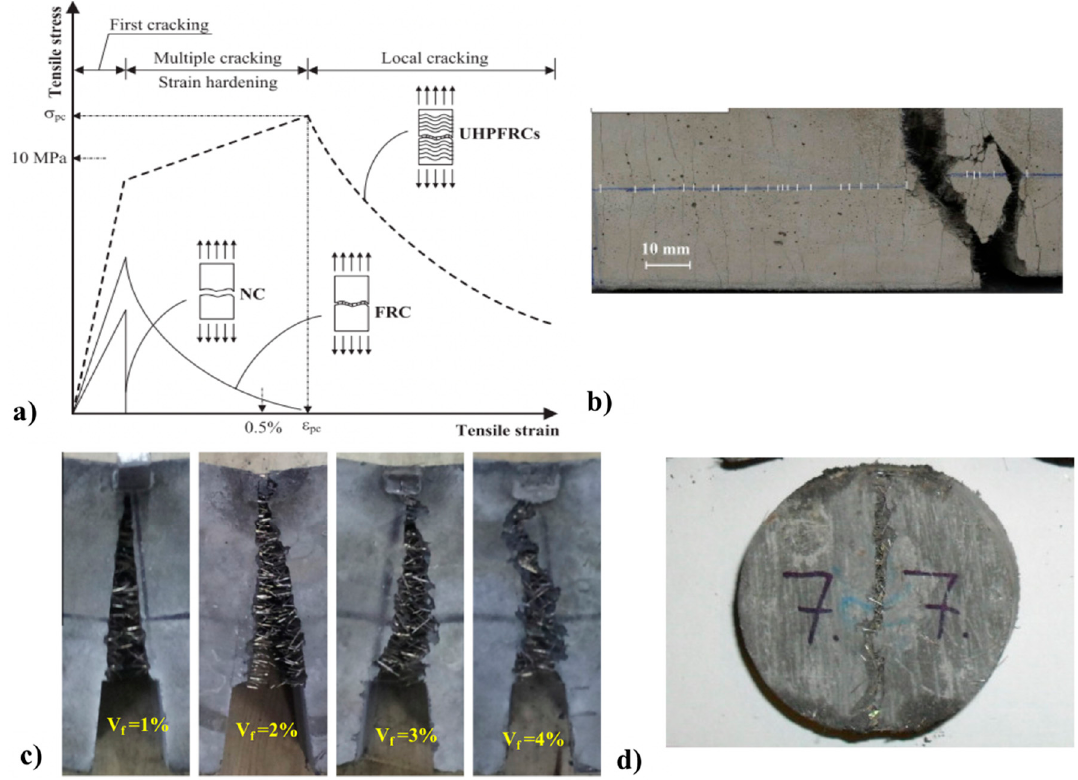
Figure 1. Benefit of using fiber in concrete ( a ) a comparison of different types of concrete in tensile stress and strain, ( b ) cracks in SHCC, ( c) crack mouth opening in notched beam for different volume of steel fiber fibers and ( d ) FRC damaged in a splitting test [6–9] .